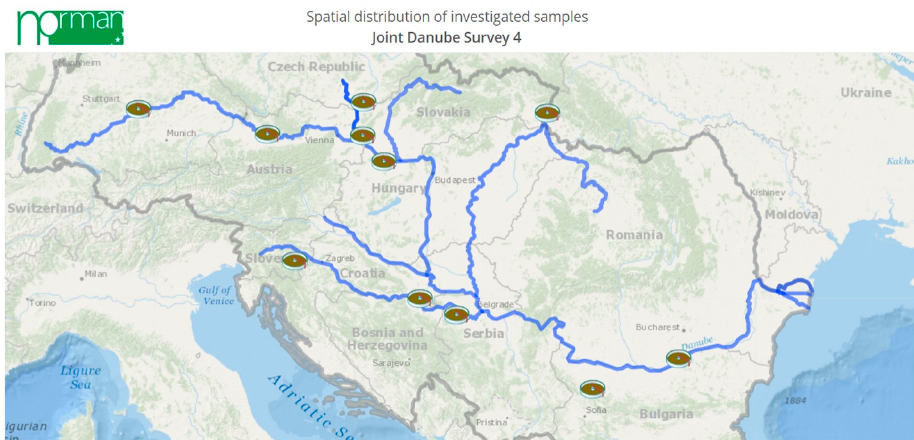
Figure 1. Spatial distribution of the investigated wastewater effluent samples. An online interactive map is available at https://norman-data.eu/JDS4_Samples (accessed on 23 November 2022).